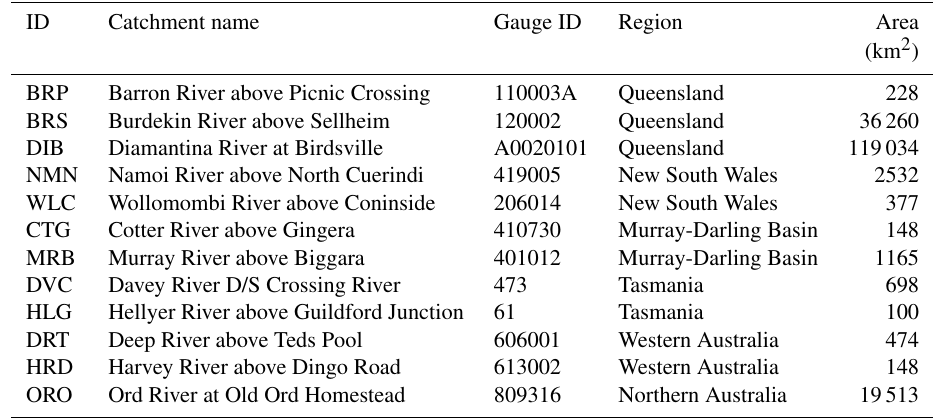
Table 1. Catchment ID, catchment name (river and gauging location), gauge ID, region and catchment